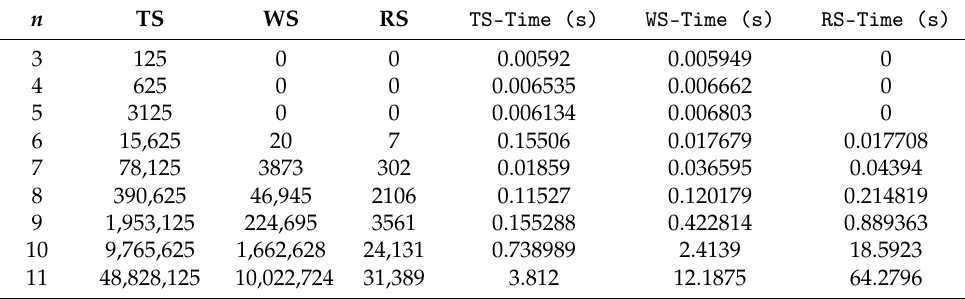
Table 5. M = 5, k 1 = 200, average of ten